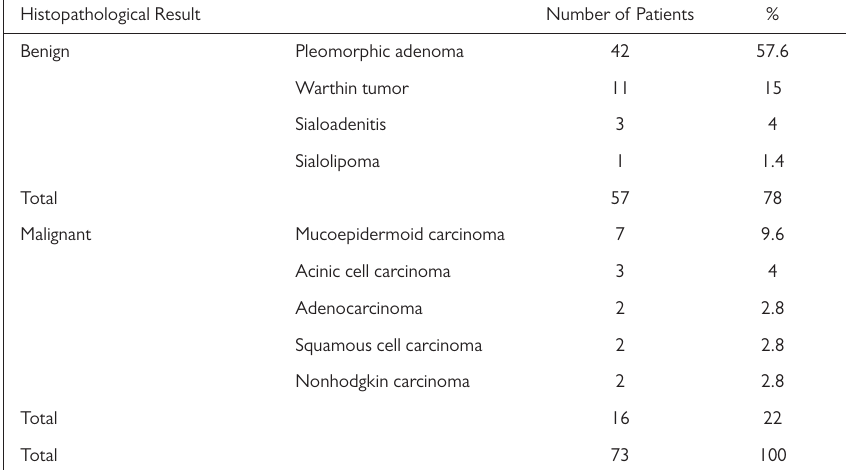
Table 2. Histopathological results of